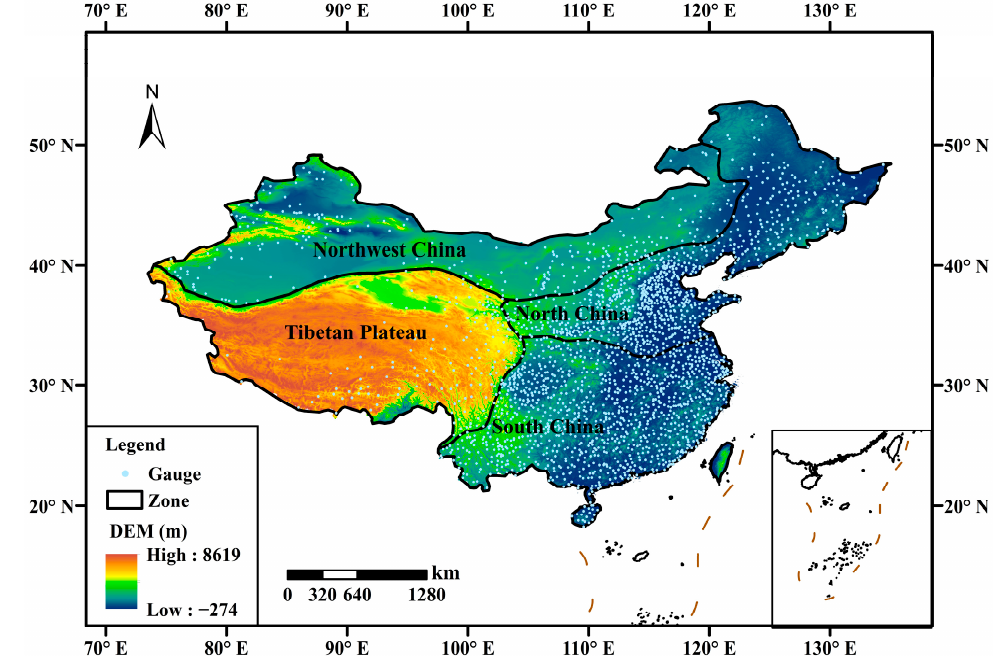
Figure 1. Locations of the rain gauges in the four subregions of China.